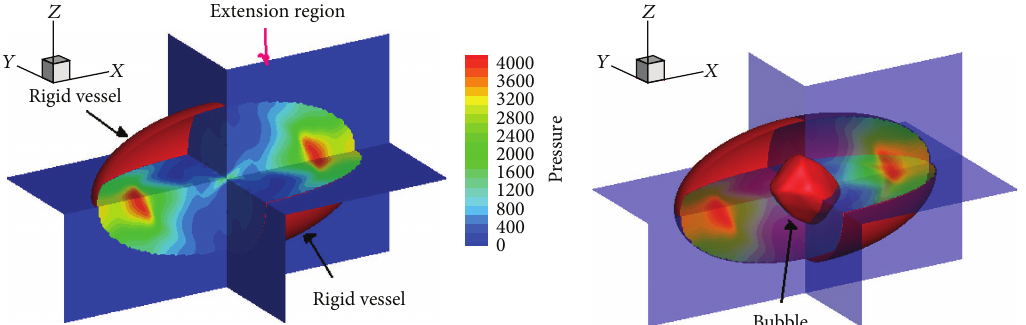
Figure 19: Numerical results by GFM-based algorithm 𝑡 = 0.816 ms. Left: pressure cloud pictures, right: bubble shape (Case 6).